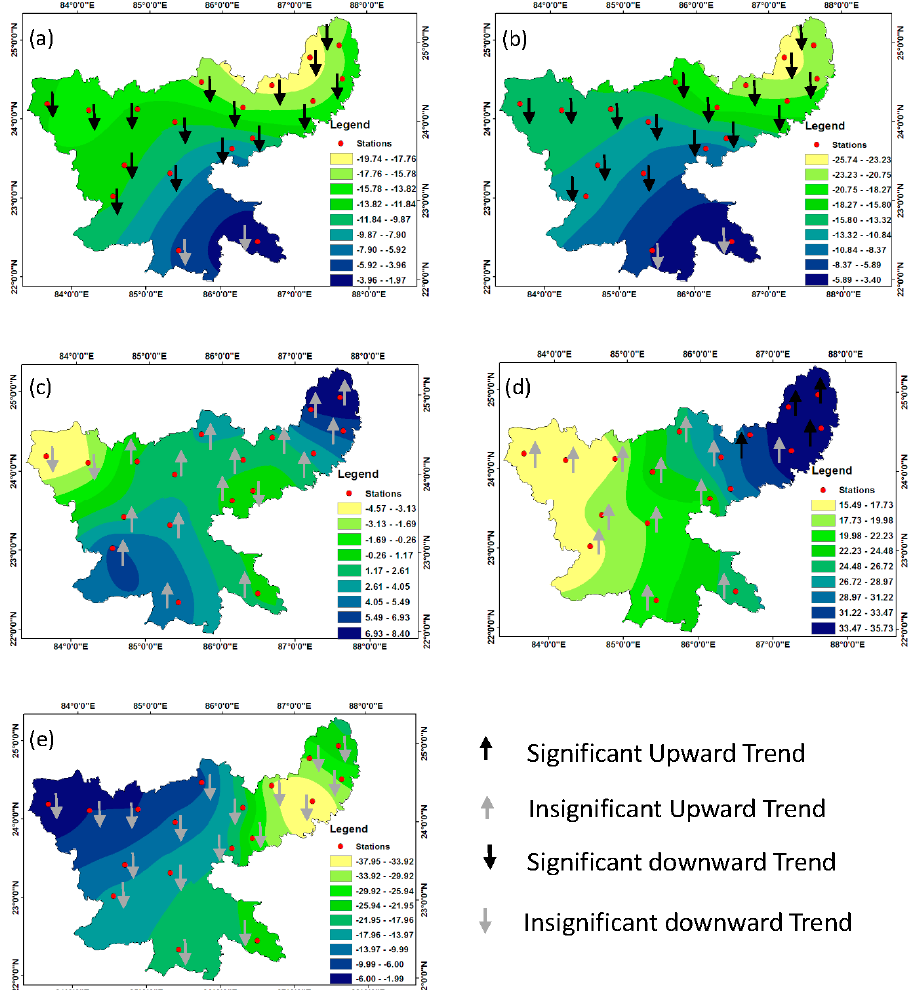
Figure 4. Spatial distribution of percent change over mean and trend analysis (Mann Kendall statistics) for period 1901-2002 of ( a ) Annual; ( b ) Monsoon; ( c ) Pre-monsoon; ( d ) Post-monsoon and ( e ) Winter season. Table 2. Sen’s slope ( β ) value of Annual and Seasonal rainfall (1901–2002).